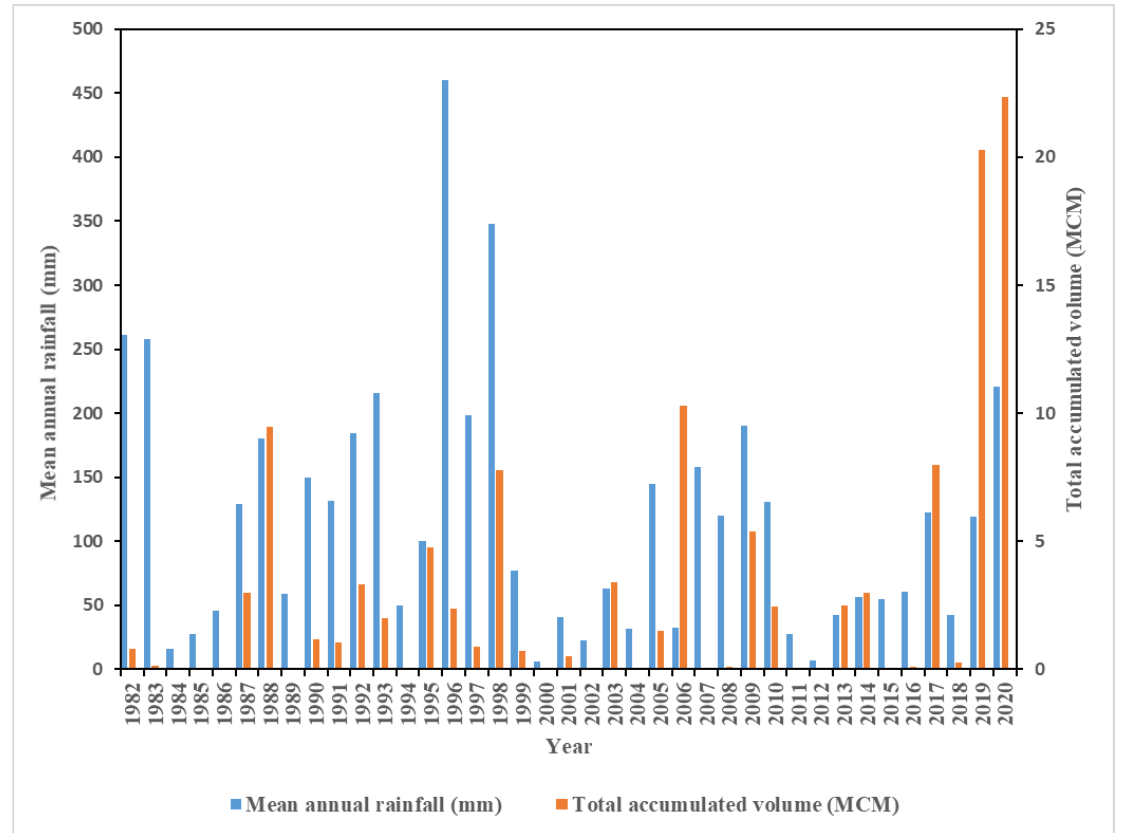
Figure 14. Total annual rainwater accumulated behind dams in the period 1982 – 2020.